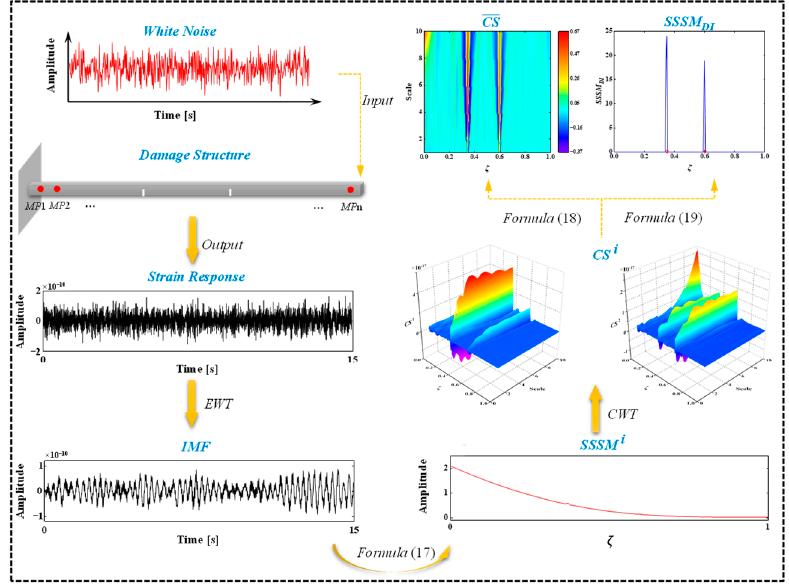
Figure 1. Flow chart of CWT-SSSM feature-based damage identification.